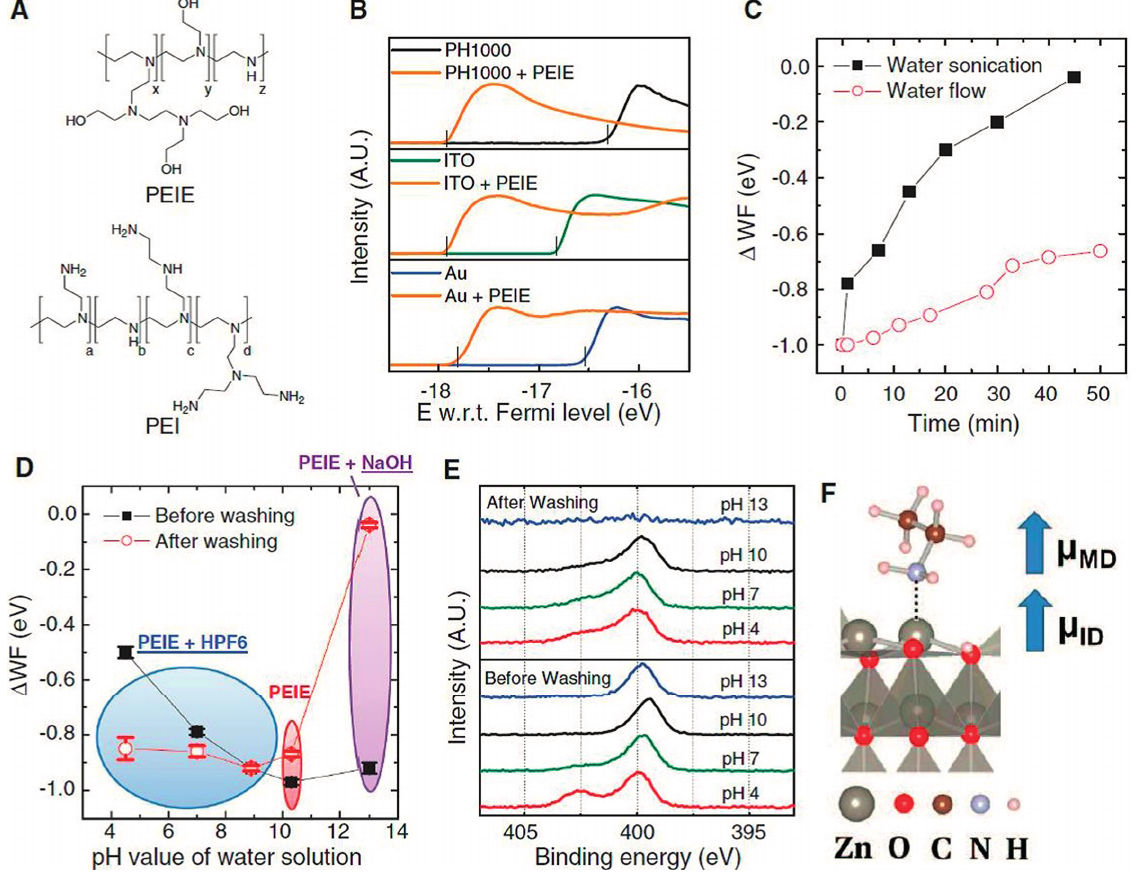
Figure 8. ( A ) Chemical structure of polymer IFL materials PEIE and PEI; ( B ) Photoemission cutoff obtained via UPS for high conductivity PEDOT:PSS PH1000 (H.C. Starck